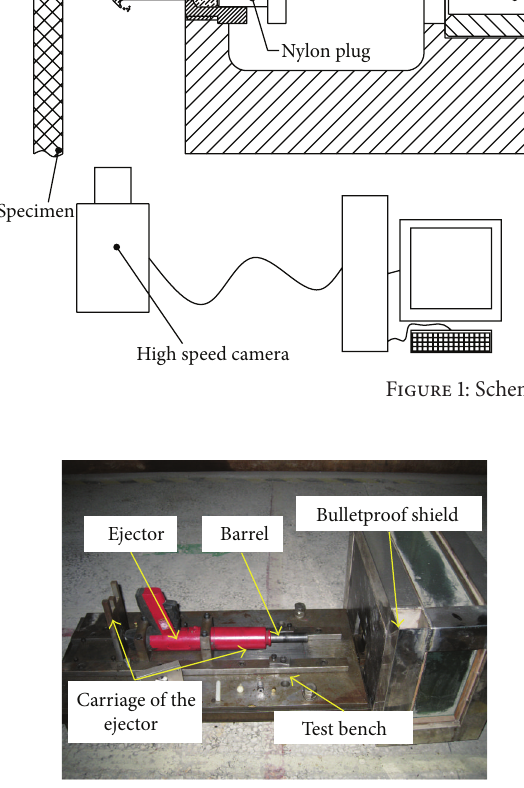
Figure 2: The photo of the experimental setup.